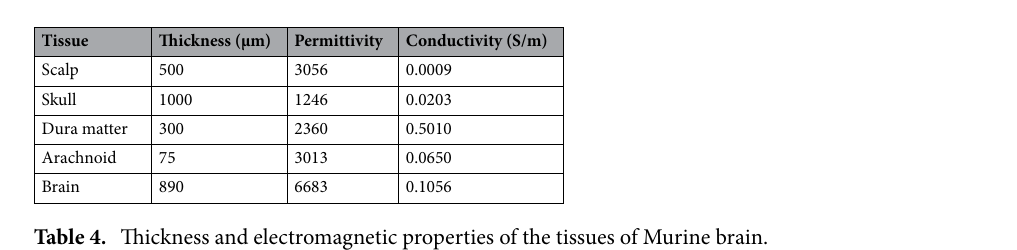
Table 4. Thickness and electromagnetic properties of the tissues of Murine